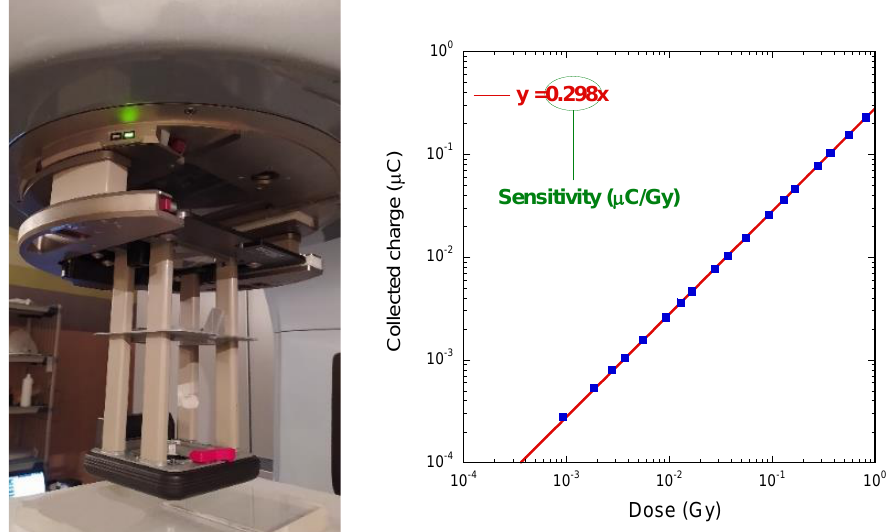
Figure 7. ( left ) The electron applicator used for characterizations under electron beams. The detector, inserted into a 3 cm thick Plexiglas ® slab at the LINAC isocenter, is visible on the bottom; ( right ) Total collected charge as a function of the dose acquired for high-energy pulsed electron beams.